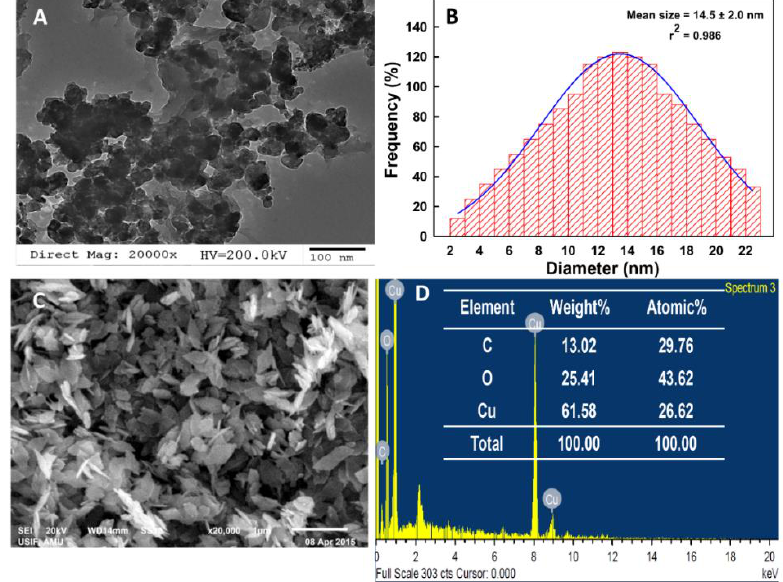
Figure 3. Electron microscopic analyses of CLE-CuONPs. ( A ) demonstrates TEM images of CLE-CuONPs; ( B ) depicts the particle size distribution in TEM images; ( C ) shows scanning electron microscope (SEM) micrographs of CLE-CuONPs and ( D ) is the energy dispersive X-ray (EDS) spectrum showing the percentage of C, O and Cu elements in CLE-CuONPs.